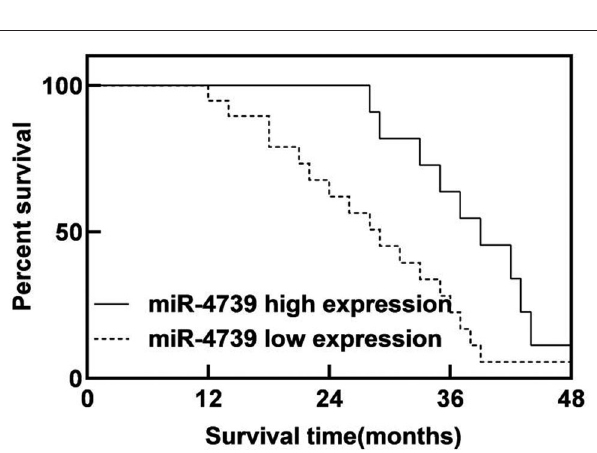
FIGURE 3 | Relationship between miR-4739 expression level and prognosis of patients with GC.